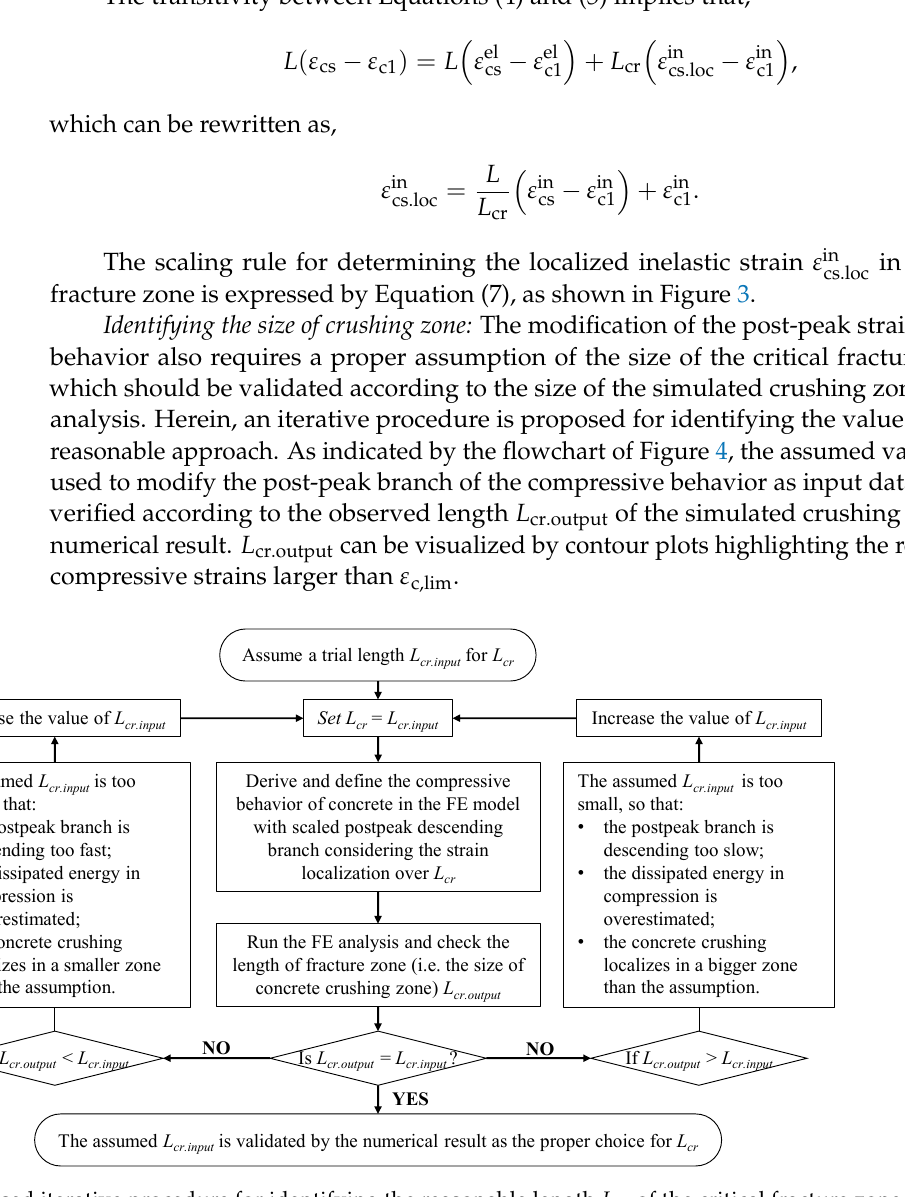
Figure 4. Proposed iterative procedure for identifying the reasonable length L cr of the critical fracture zone.